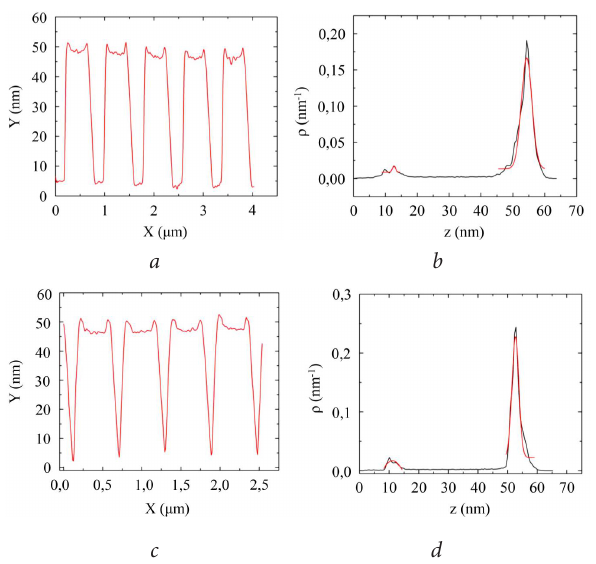
Fig. 2. AFM analysis of molded structure : a – Topology of molded structure with period 800 nm and 400 nm width hole; b – Statistic function for period 800 nm; c – Topology of molded structure with period 600 nm and 200 nm width hole; d – Statistic function for period 600 nm